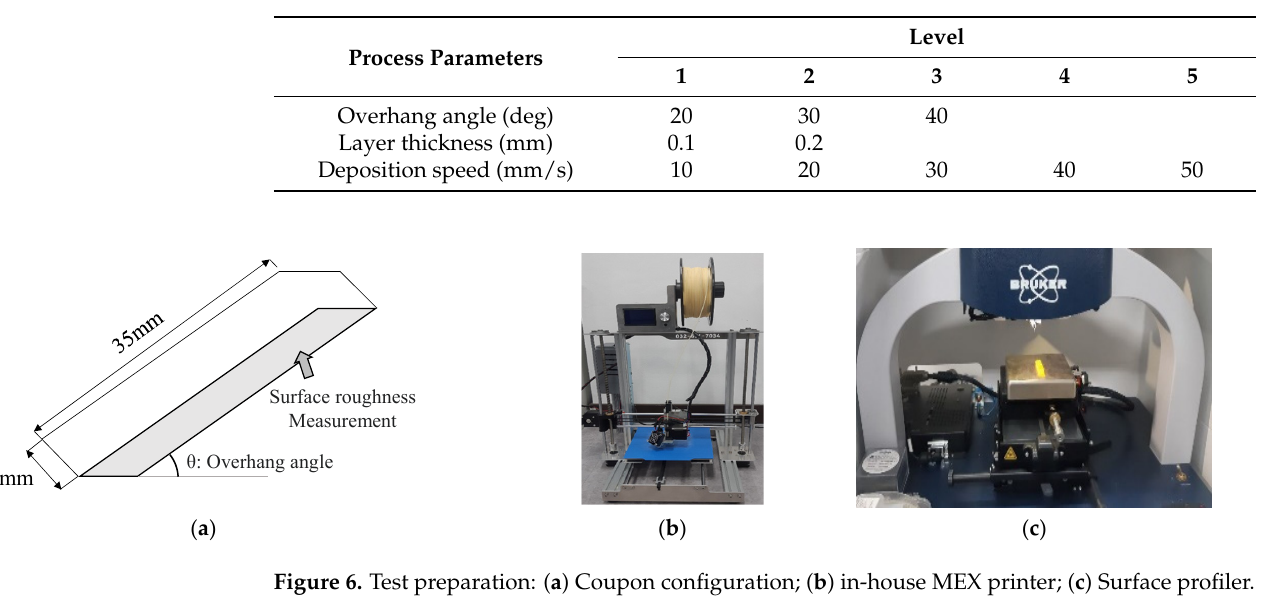
Table 5. Mean value (standard deviation) of measured surface